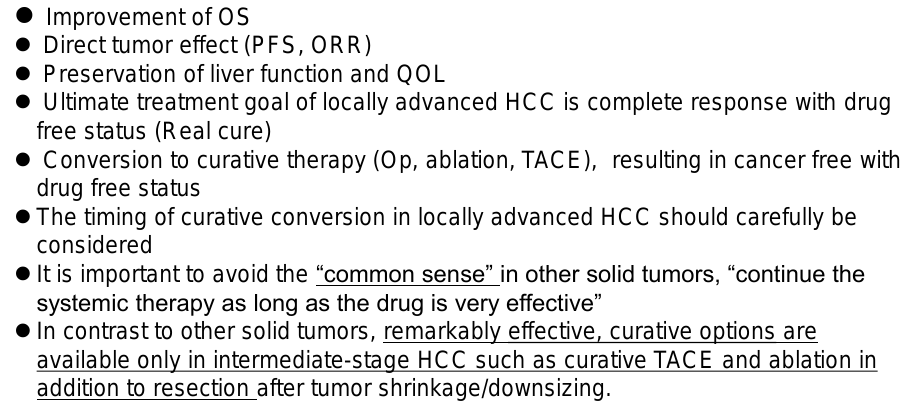
Figure 5. Treatment strategy of intermediate-stage hepatocellular carcinoma. Response of LEN– TACE sequential therapy strongly depends on tumor hypoxic/necrotic change, including with lenvatinib. On the other hand, curative conversion in ABC conversion strongly depends on the tumor shrinkage/reduction effect from atezolizumab plus bevacizumab combination therapy. mALBI grade, modified albumin-bilirubin grade; TACE, transarterial chemoembolization; TKI, tyrosine kinase inhibitor; SNEG, simple nodular type with extra growth; CMN type, confluent multinodular type; ABC conversion, atezolizumab plus bevacizumab followed by curative conversion; LEN, lenvatinib. In the field of oncology, the traditional treatment concept for systemic therapy for other types of cancer and even advanced HCC is to continue the administration of the same drugs as long as they are effective (compared to SD). However, unlike other carcinomas, in intermediate-stage HCC it is possible to achieve cancer-free and drug-free status by treating the patient with a curative option, such as resection, ablation, or curative TACE, if a significant tumor reduction is obtained. Therefore, the timing of the initiation of curative conversion should be always carefully considered. As 44% of cases respond to this combination therapy, this indicates that one out of two patients could potentially receive curative conversion (ABC conversion). Since the ultimate treatment goal with a locally advanced HCC is to reach cancer-free or drug-free status, we must exclude the preconceived treatment concept that good effects with the present systemic therapy should be continued with the same agent (Figure 4). Instead, we should switch to the